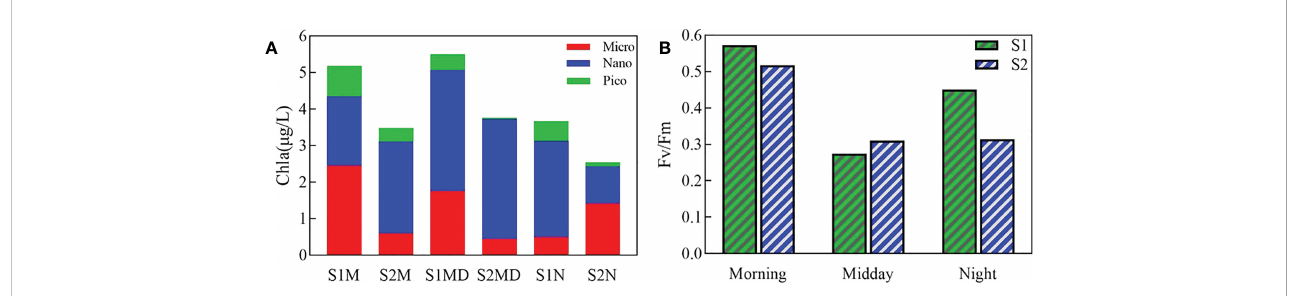
FIGURE 5 Size-fractionated chlorophyll a composition (A) and the maximum quantum yield ( F v /F m ) (B) at the inlet and outlet stations. S1, the inlet site. S2, the outlet site. M represents morning, MD represents midday, and N represents